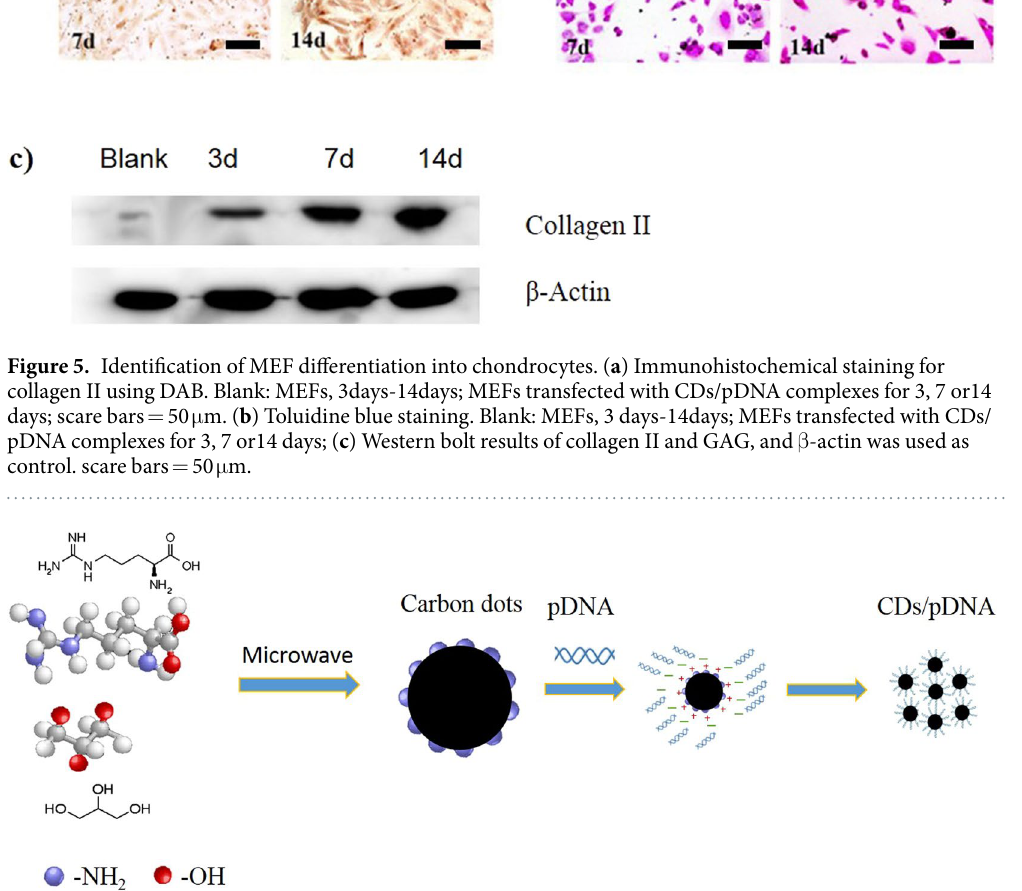
Figure 6. Sketch of the formation of CDs and